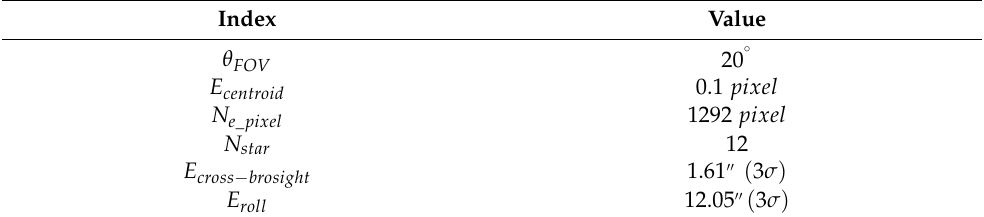
Table 5. The design parameters and predicted accuracy of the DST.